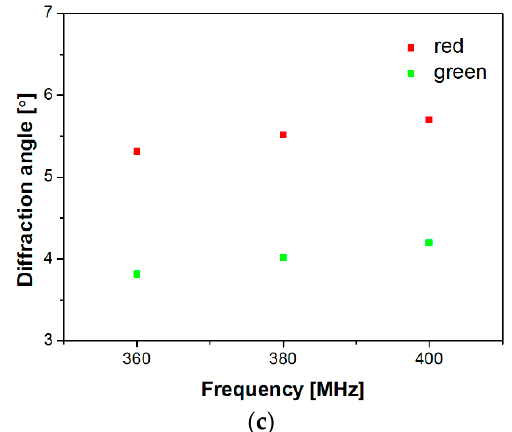
Figure 9. ( a ) CCD views by applying different frequencies from chirp IDTs. ( b ) Contour plot and color mapping with respect to different SAW frequencies. ( c ) Diffraction angle vs. SAW frequency in terms of the wavelength of the incident light beam.